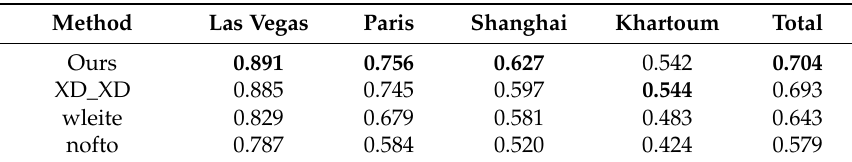
Table 6. F1-scores obtained from different